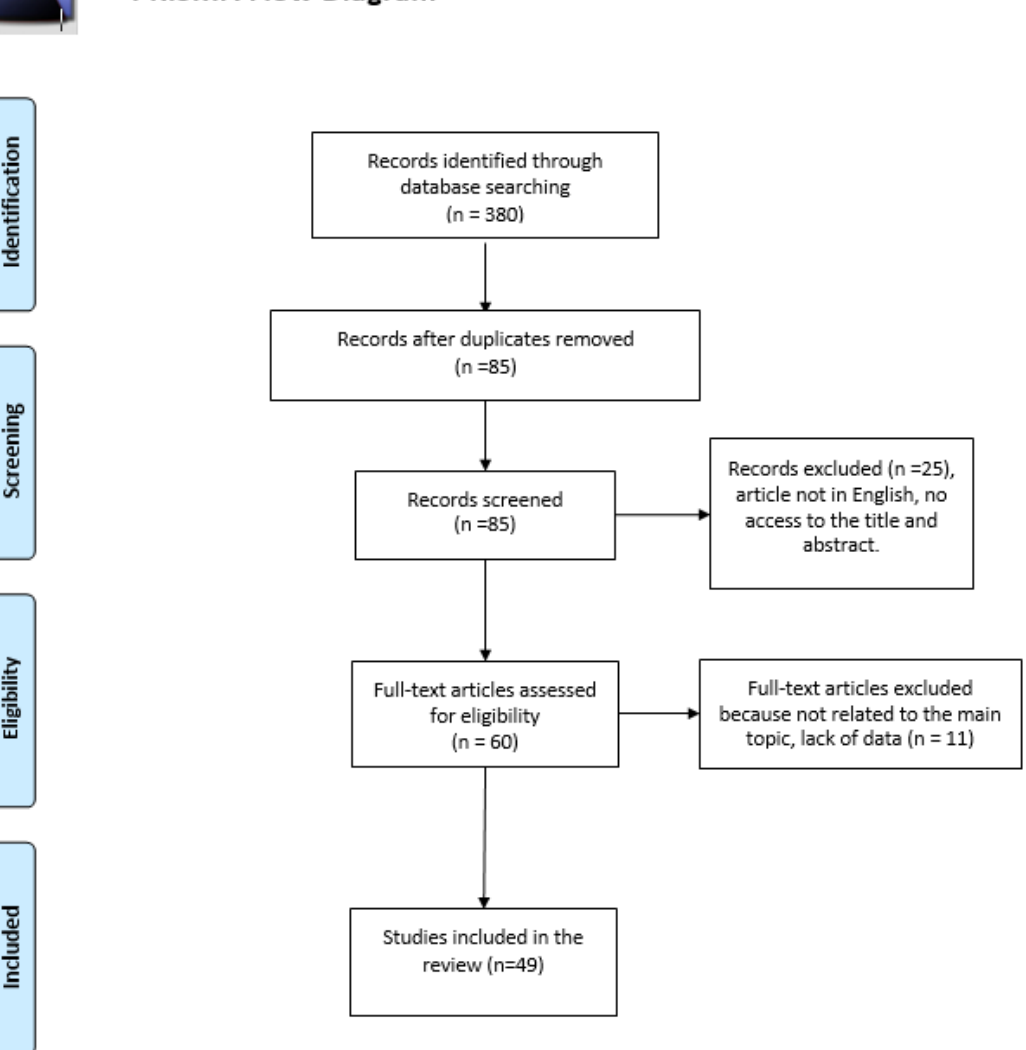
Figure 2. Review preferred reporting items for systematic review (PRISMA) flow diagram.